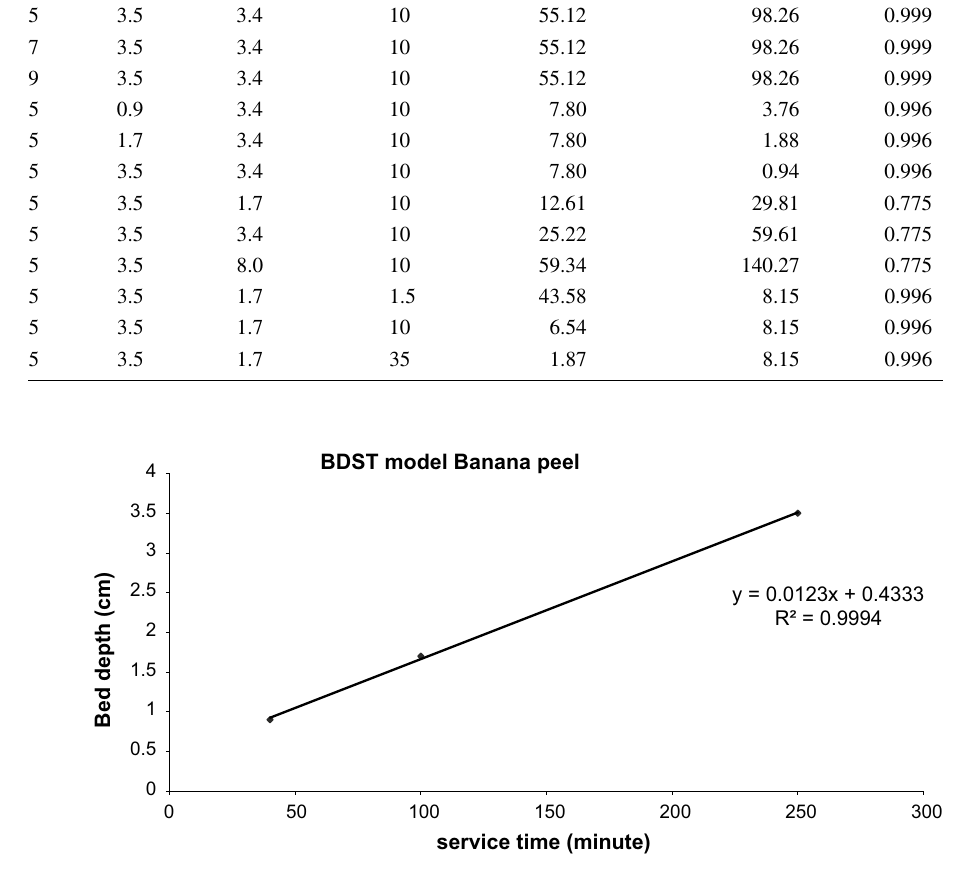
Table 3 Calculated constants of Thomas model at different conditions using linear regression analysis